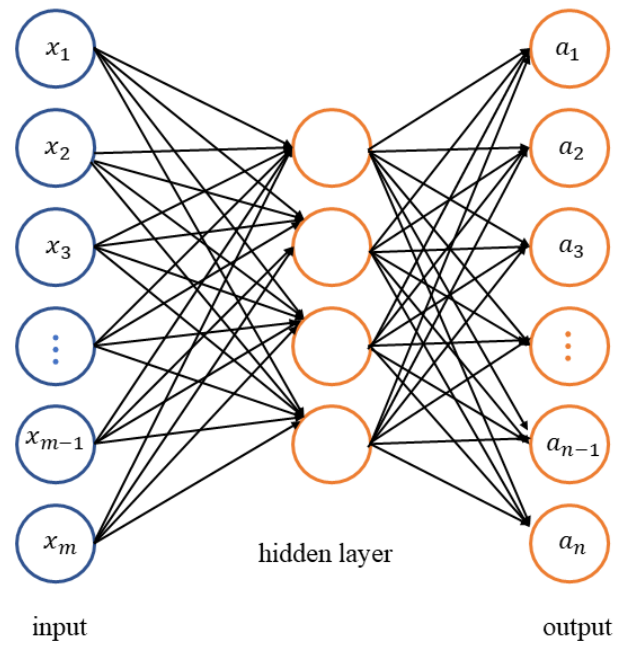
Figure 1. Structure of sparse